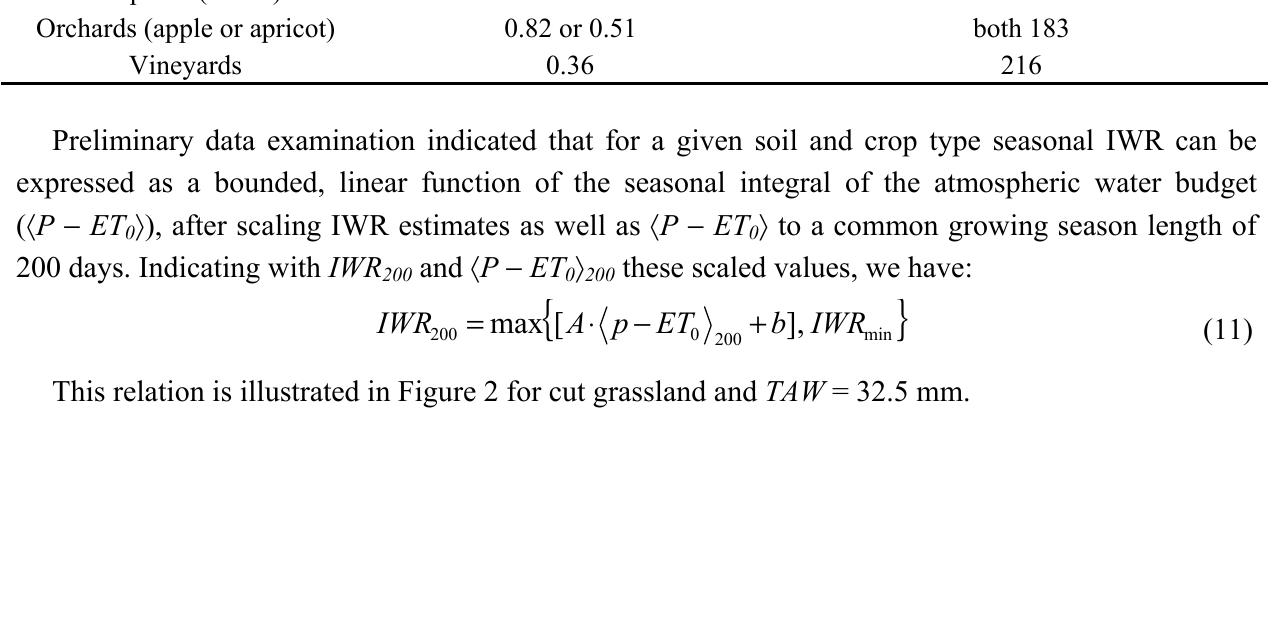
and growing season length based on simulations c